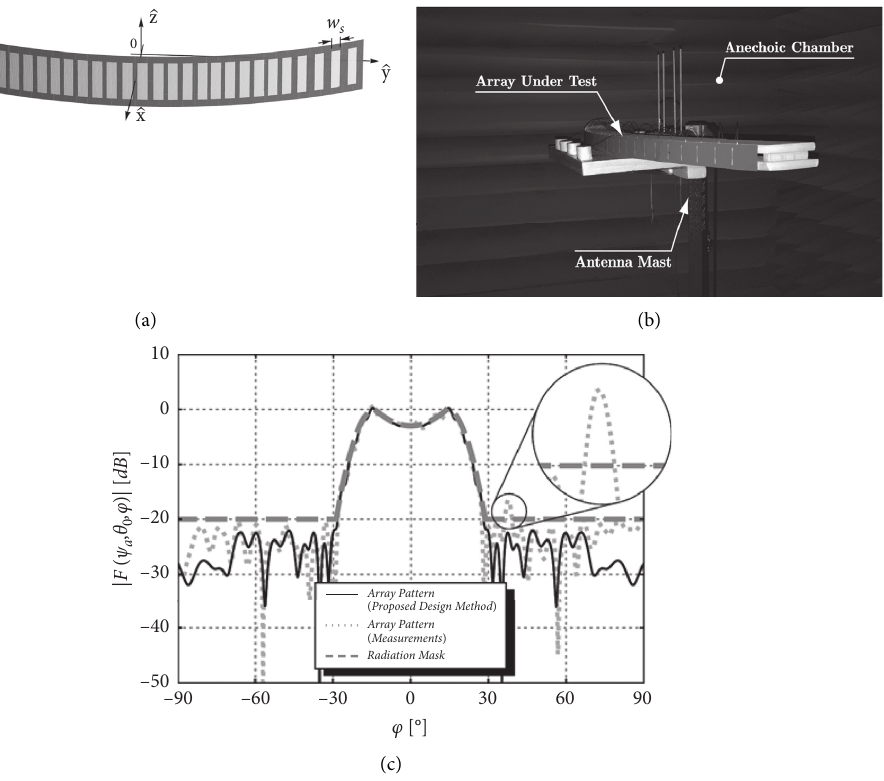
Figure 12: Synthesized sparse 23 λ -long arc array aperture with curvature radius of 21 λ and 30 antenna elements that features an isoflux radiation pattern [59]: (a) physical implementation based on 0.607 λ × 0.0367 λ slot antennas; (b) 5 GHz prototype under test; (c) synthesized and measured array radiation